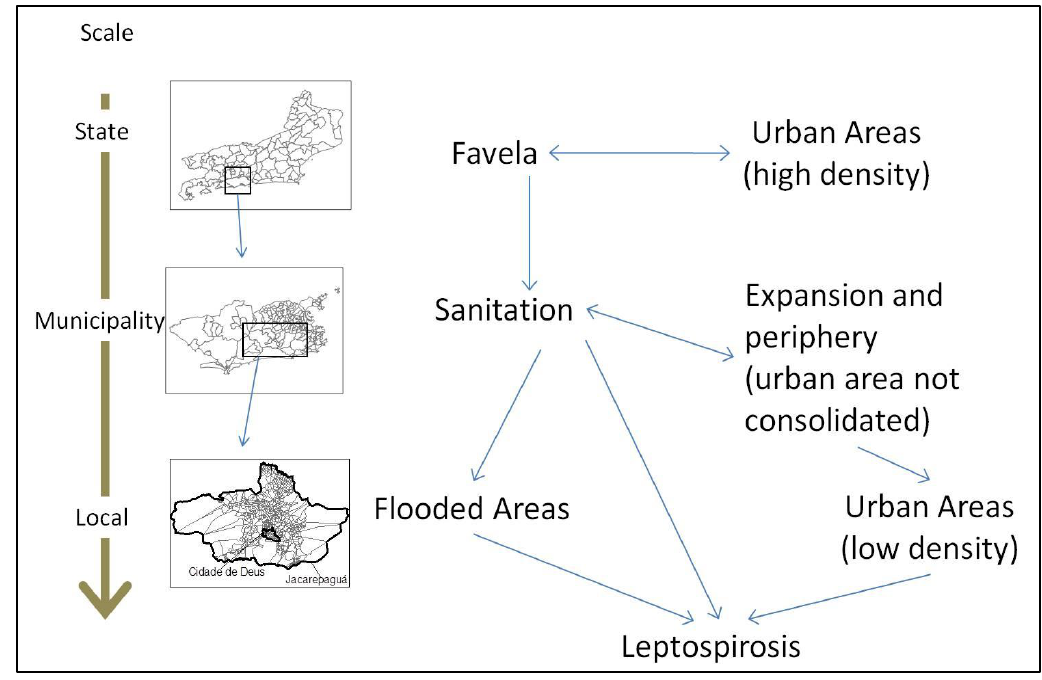
Figure 4. Multiscale model for leptospirosis determinants